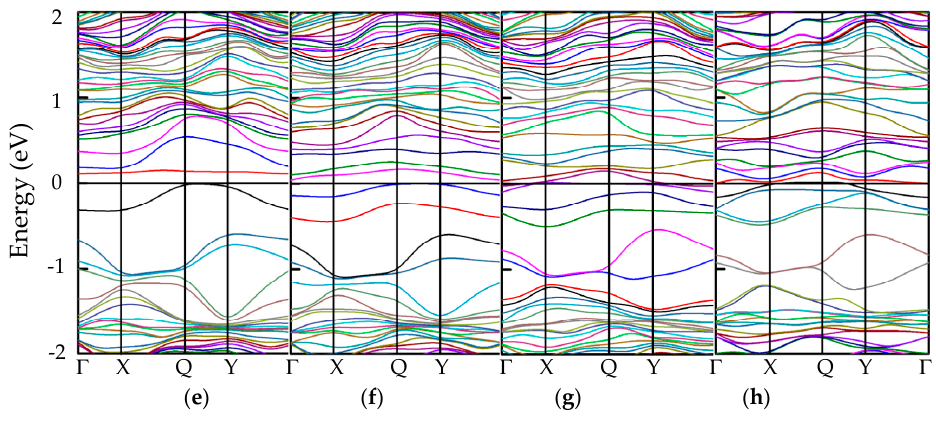
Figure 6. The band structures of doped phosphorenes with different impurity atoms: ( a ) P 63 Al 1 , ( b ) P 62 Al 2 , ( c ) P 61 Al 3 , ( d ) P 60 Al 4 , ( e ) P 63 Al 1 , ( f ) P 62 Cl 2 , ( g ) P 61 Cl 3 , and ( h ) P 60 Cl 4 . The Fermi level is shifted to zero.